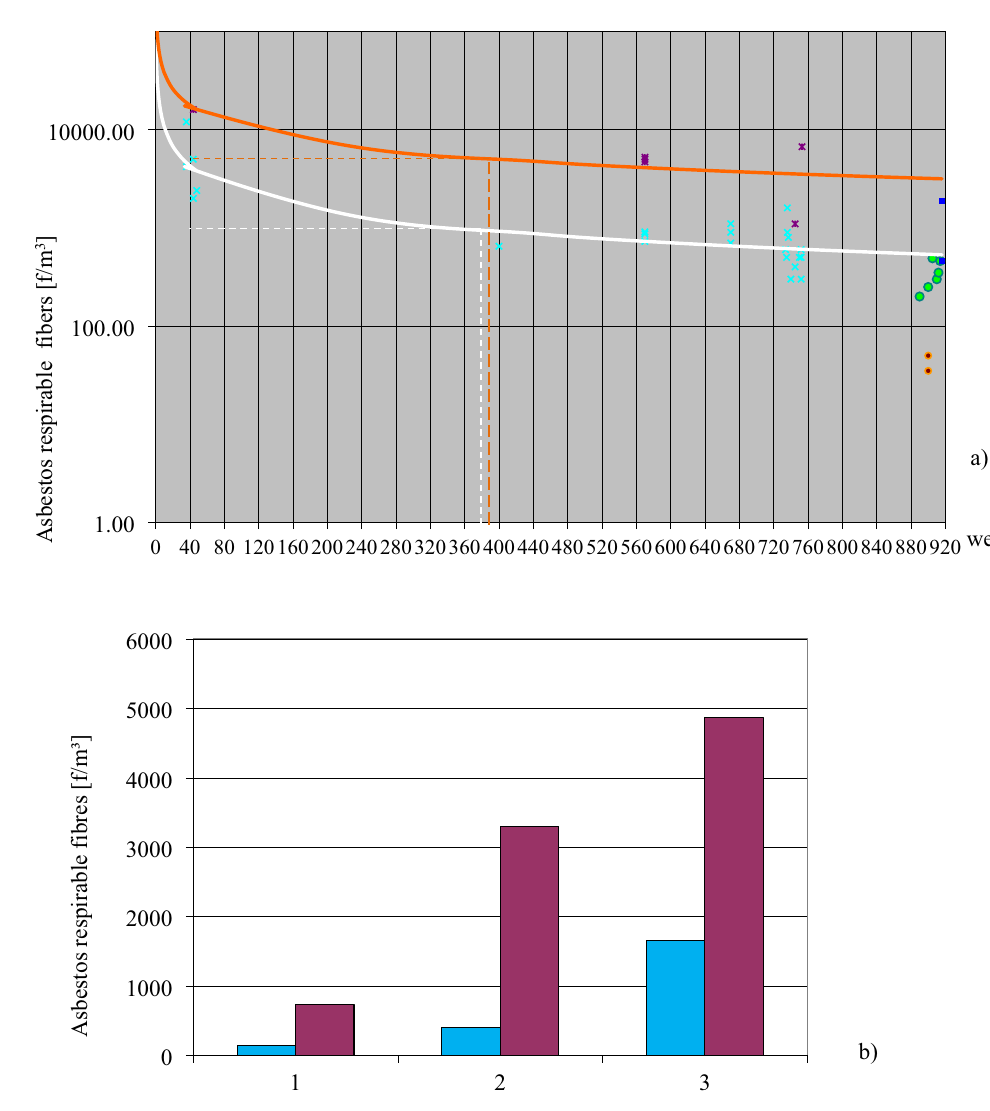
Figure 2. Differences in the asbestos dust concentrations in the air ( a ) The trend of changes in asbestos dust concentrations in the “BOLETICE” system building. Dark purple times: The determination of air samples taken in a dynamic way (one point means the average of two measurements made at the same time and in the same room). Concentration change trends at such samplings were marked as an orange curve. Light blue times: The averaged values of dust concentration obtained during normal building use (standard user activity, working central ventilation, without cabinet fans). Concentration change trends were presented as the white color curve. Measurements made 12 months after the building was no longer in use (after approximately 19 years). The tests were carried out in the same rooms during its operation. Green circle: Test conditions: mechanical ventilation and heating excluded in the building, no operational vibrations related to the use of the building. Dynamic air sampling (analogous to earlier techniques: activities to run dust seated on horizontal surfaces). Blue square: Measurements made at the same time in rooms with fresh, large damage to the sandwich wall created after the building was no longer in use: exposed, damaged, soft products (friable) – “PYRAL” board. Dynamic air sampling: the average asbestos dust concentration was 1200 f./m 3 . Red circle: Measurements made outdoors at ~ 8 m from the building. The mean concentration was < 100 f/m 3 . ( b ) The asbestos dust concentration differences in the air of the three rooms with different levels of dust concentration. Turquoise—static sampling, magenta—dynamic sampling. Approximately two years before the end of the measurements, the building was taken out of use. The overall changes are illustrated by the curve based on average sample values taken statically and dynamically in Fig. 3. This figure shows the same individual 80 measurements, depending on the sampling method, separately and after combining all values into one chart (Fig. 3c). Figures 2 and 3 should be analyzed together because they are shown in the same coordinate system (Y—fiber concentration, X—time in weeks) and present results that complement each